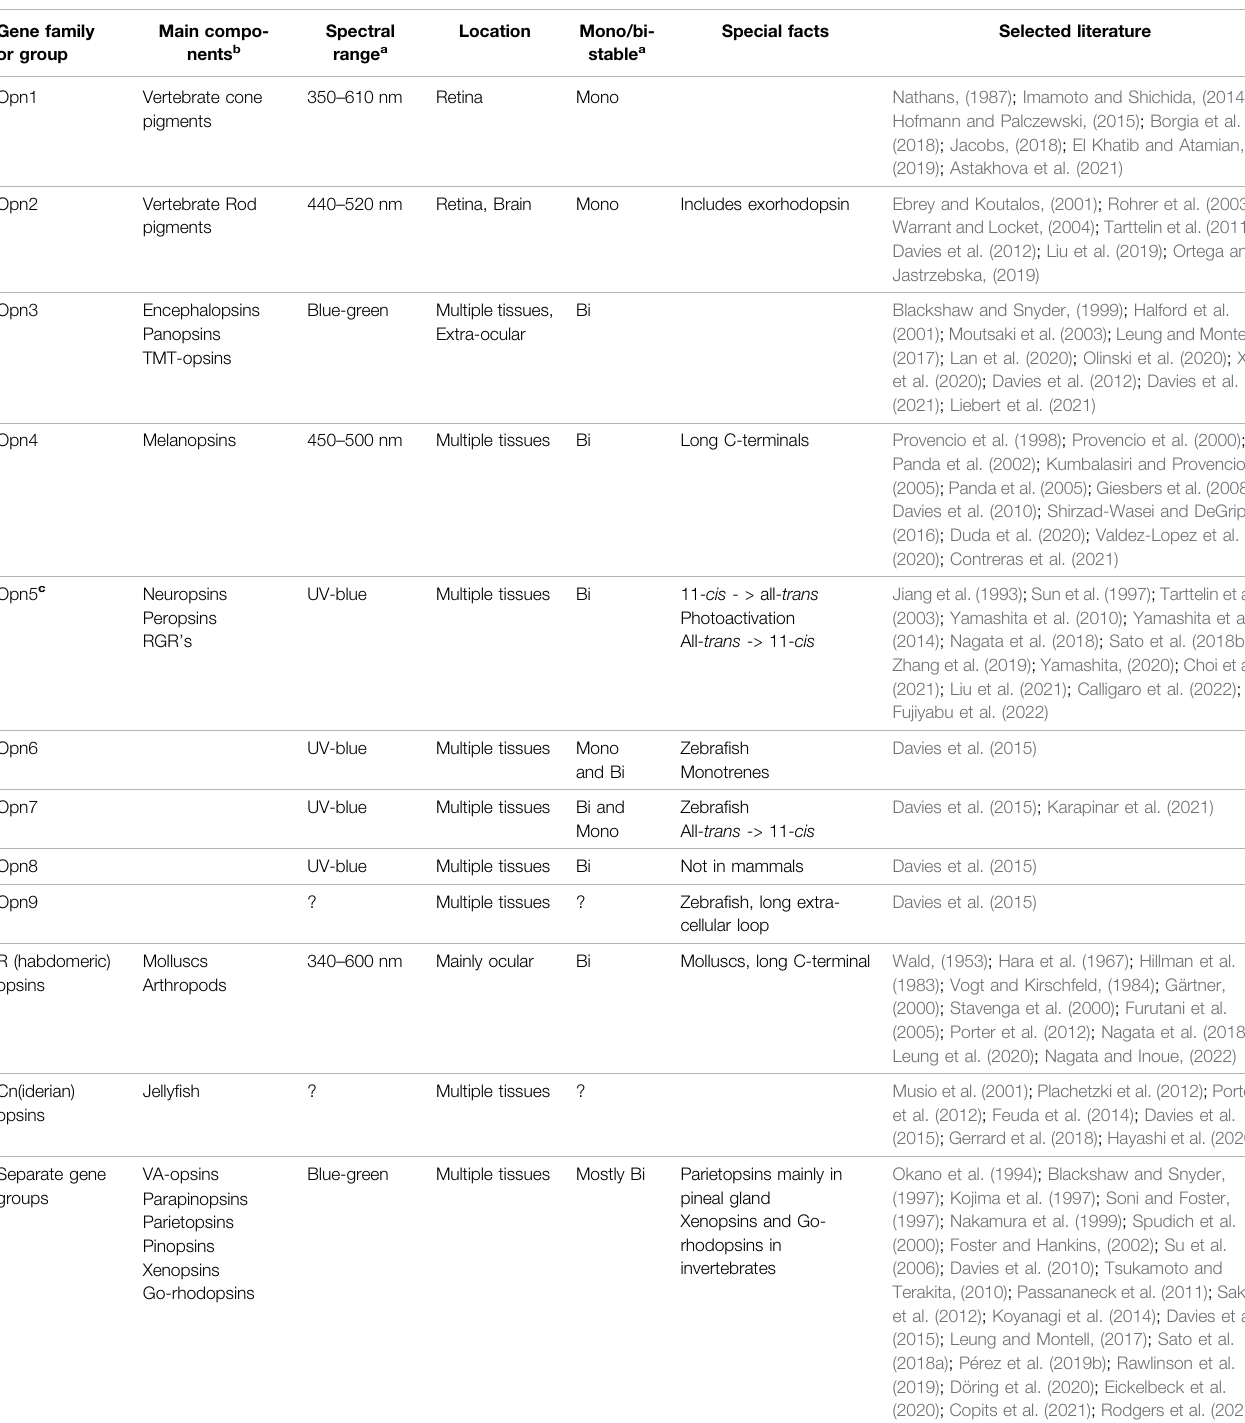
TABLE 2 | Current classi fi cation of type-2